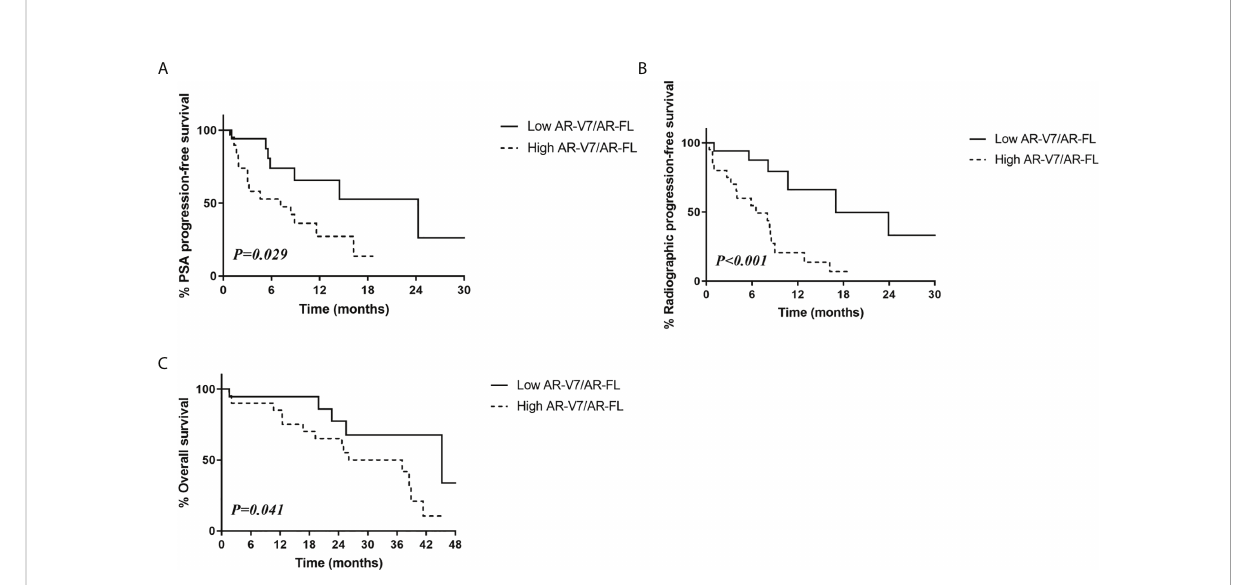
FIGURE 2 Relationship between survival outcomes and AR-V7/AR-FL ratios in CRPC patients treated with AR-targeting therapy. (A) PSA progression-free survival. (B) Radiologic progression-free survival. (C) Overall survival.